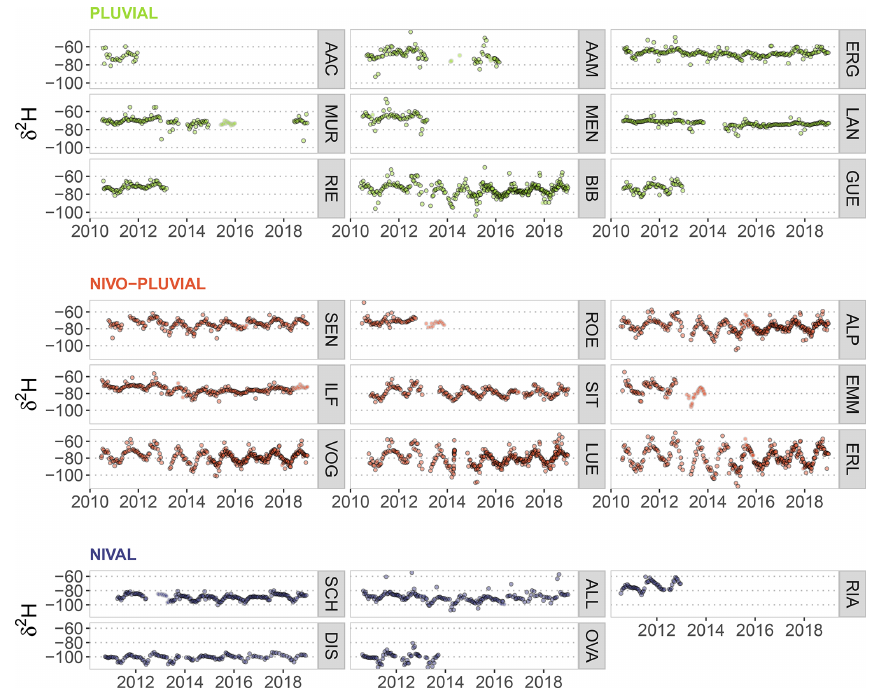
Figure 3. Fortnightly time series of δ 18 O. The colours indicate the regime type to which the catchments can be assigned. Note the different y -axis scaling for the nival catchments. Samples that are flagged in the data are plotted as symbols without border.